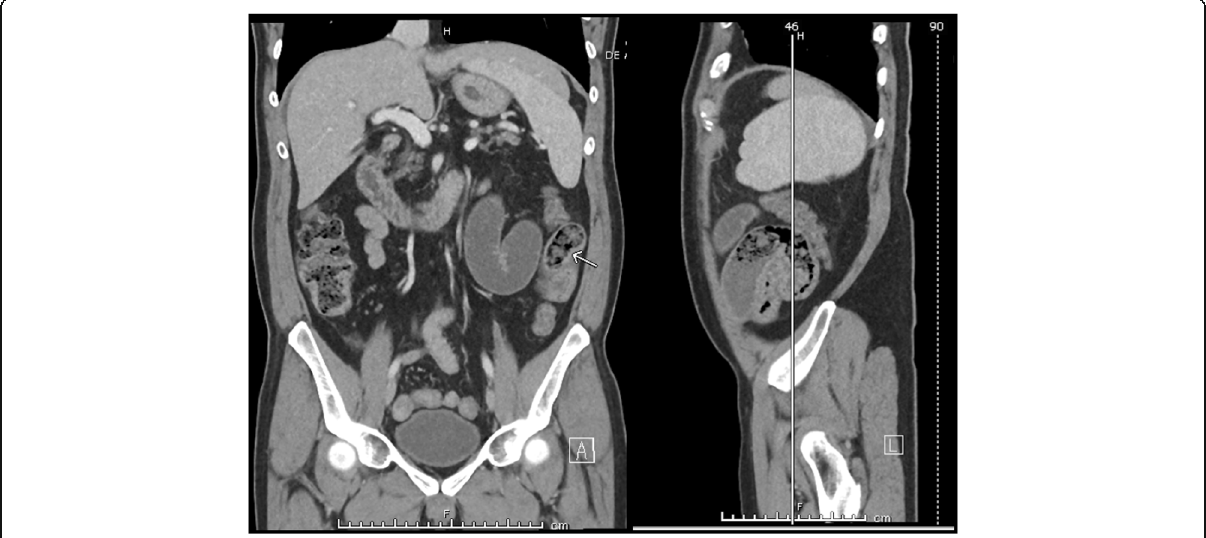
Fig. 4 The small bowel feces sign. On further inspection, the patient ’ s CT scan was determined to have a characteristic small bowel feces sign in the mid-jejunum, just proximal to the suspected transition point. Defined in 1995 as the presence of gas and particulate material in a dilated segment of the small bowel, the small bowel feces sign indicates fecal content in the small bowel and is due to intraluminal stagnation of enteric material